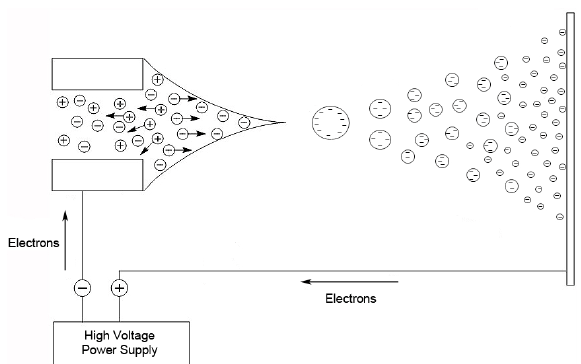
Figure 2. Schematic of electrospray process. Adapted from [32].